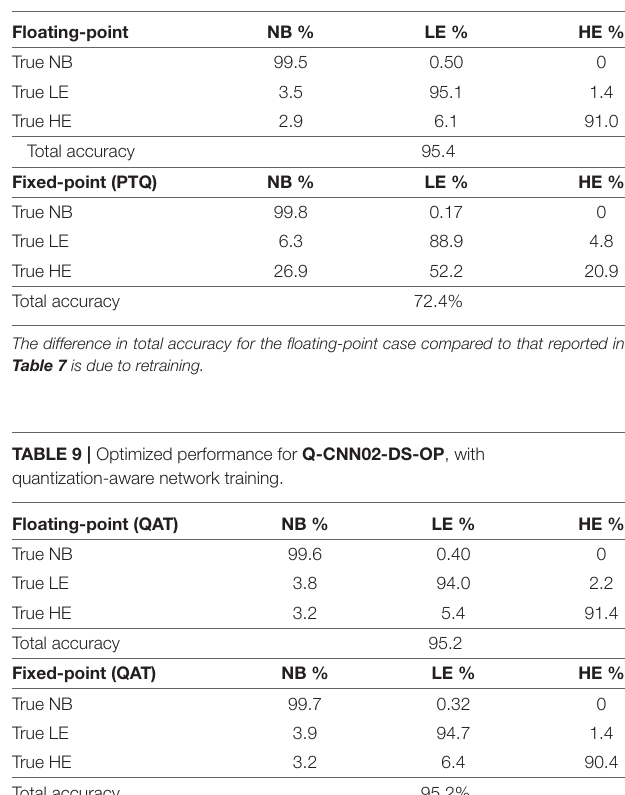
TABLE 8 | Optimized performance for CNN02-DS-OP , without quantization-aware network training.